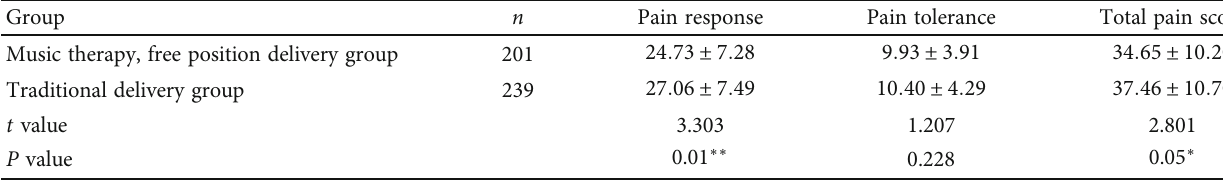
Table 2: Chinese PLPQ score of parturients in two